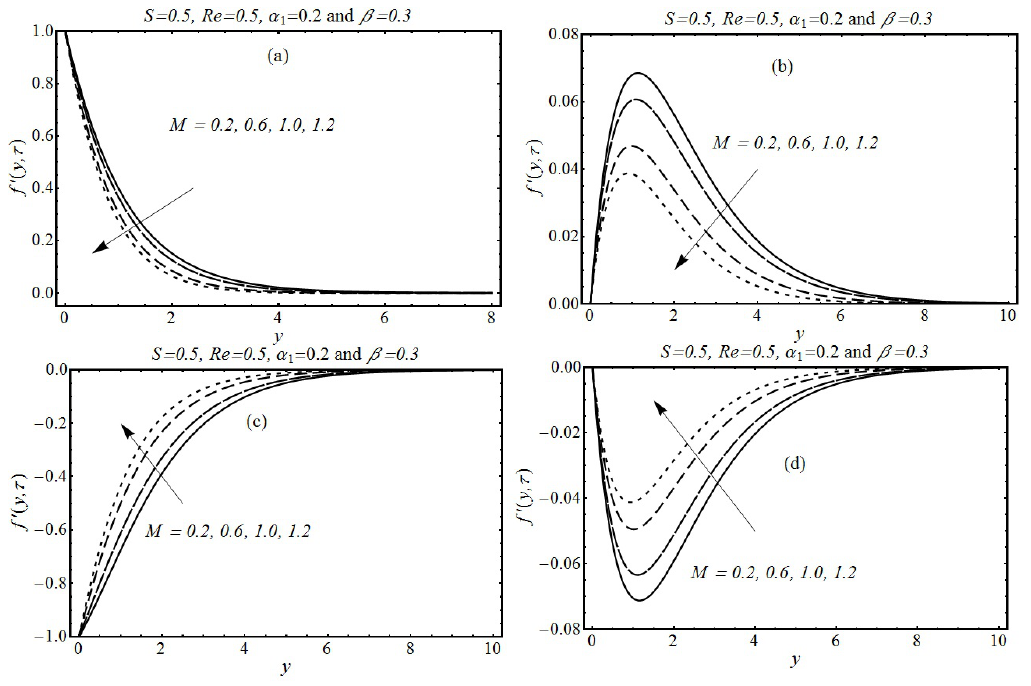
Figure 6: Effects of M on velocity profile (a) τ = 8.5 π , (b) τ = 9 π , (c) τ = 9.5 π , (d) τ = 10 π .